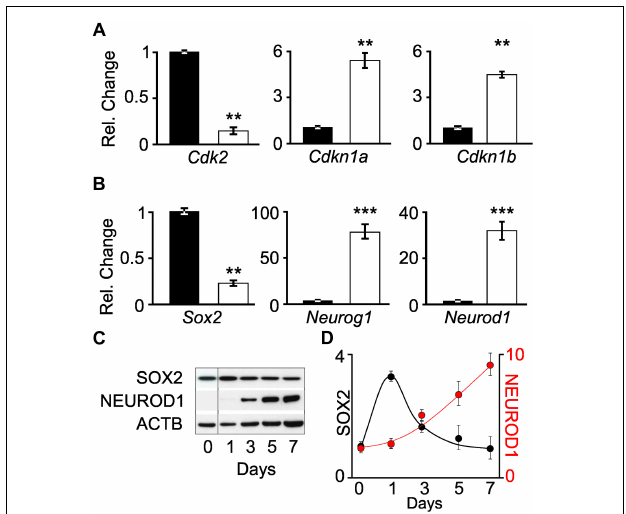
FIGURE 2 | Changes in transcript and protein levels in proliferating iMOP and iMOP-derived neurons. Relative changes in (A) cell cycle genes ( Cdk2 , Cdkn1a , and Cdkn1b ) and (B) transcription factors ( Sox2 , Neurog1 , and Neurod1 ) using quantitative PCR (qPCR) in proliferating iMOP (black) and iMOP-derived neurons cultured in the presence of 1 µ M K03861 (white) ( n = 3 independent experiments, ∗∗ p < 1 × 10 - 2 and ∗∗∗ p < 1 × 10 - 3 ). (C) Western blot of SOX2, NEUROD1, and ACTB at different time points during neuronal differentiation. (D) SOX2 and NEUROD1 protein levels normalized to ACTB at different time points ( n = 3 independent